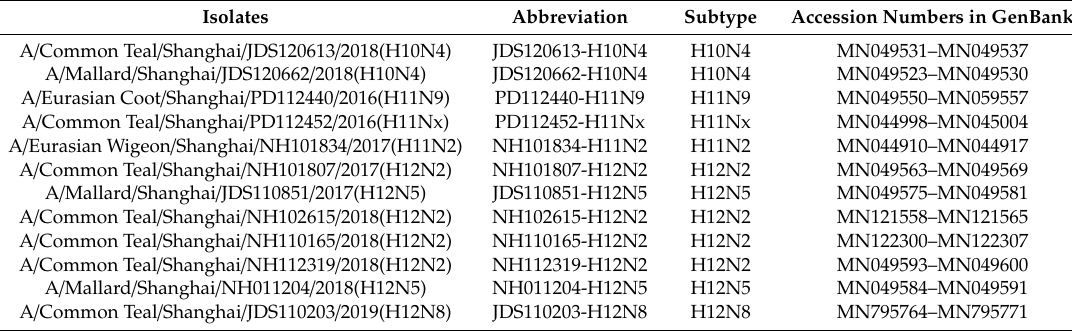
Table 1. Twelve H10–H12 isolates and GenBank accession numbers of their genomic